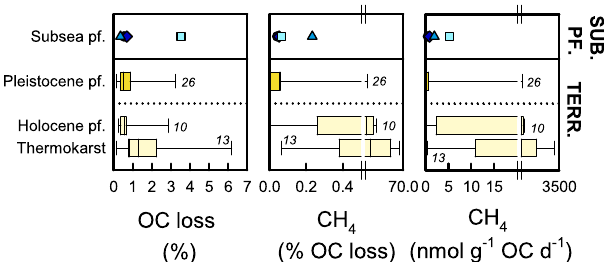
Fig.7|Comparisonofgreenhousegasproductionfromsubseapermafrostwith terrestrial permafrost. Shown are organic carbon (OC) loss, the contribution of CH 4 production to organic carbon loss, and absolute rates of CH 4 production duringthe fi rstyearofincubation.Subseapermafrost(sub.pf.)dataarefromcores 4D-13, 2D-13, 4D-12, and 1D-14 from the Buor-Khaya Bay, and data from previous studies include terrestrial, Pleistocene, and Holocene permafrost (pf.) and well as thermokarst deposits 10,22,25 . For comparability, only samples with organic carbon content <5% and incubation temperature at 4°C are included. Box plots show medianswith25thand75thpercentilesasboxlimits,minimum/maximumvaluesas whiskers, and numbers of observations in Table5).Methaneproductionwas fi rstobservedforthe1 – 5dayinterval in the 4D-13 sample, and for the 9 – 16 day interval in the 2D-13, 4D-13 and 1D-14 samples (4 – 38nmolg − 1 OCd − 1 ; Supplementary Fig. 2 and